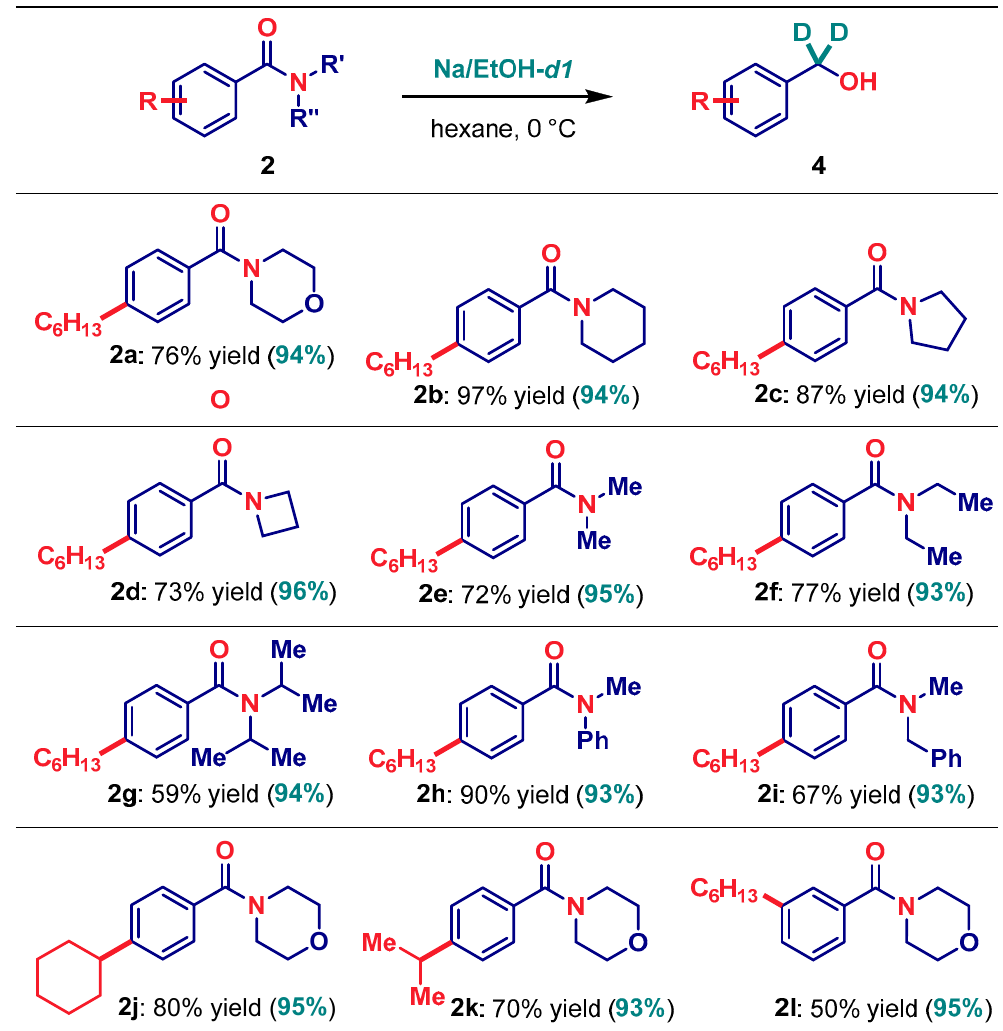
Table 5. Chemoselective Sodium Dispersion Mediated Reductive Deuteration of Aromatic Amides to [D 2 ]-Benzyl Alcohols 1 .